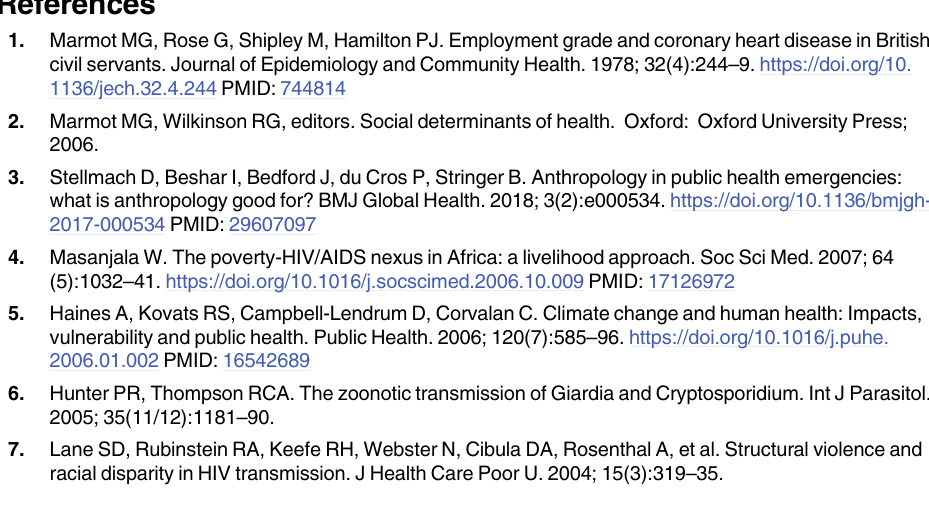
S5 Table. Odds ratios from regression analysis including both the first and second compo- nent of hope index constructed using